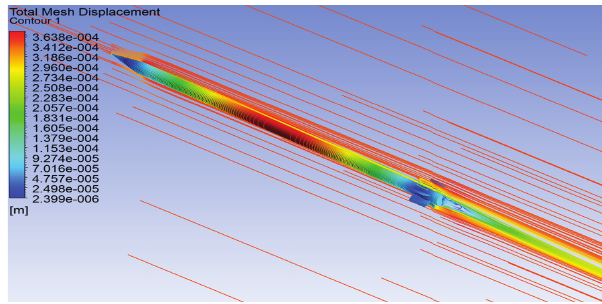
Figure 8: Total deformation and streamline contour at Ma = 1.5 and 𝛼 = 2 ∘